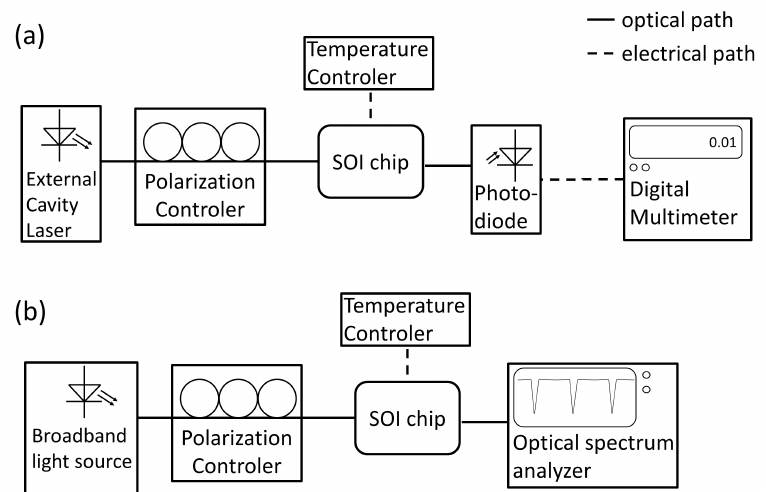
Figure 7. Schematic of typical measurement set-ups in laboratories. ( a ) The light source consists of an external cavity laser, which can tune its wavelength (tunable laser). In this case, a photodiode can be used as detector. ( b ) If a broad band light source (e.g., superluminescent diode) is employed, an optical spectrum analyzer is needed on the detector side.